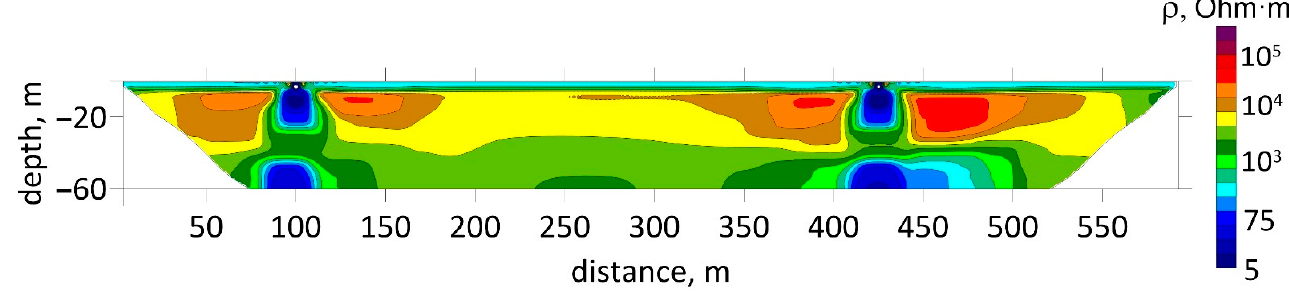
Figure 10. Resistivity model obtained by inversion of synthetic data, with well-defined low-resistivity features beneath the fence.